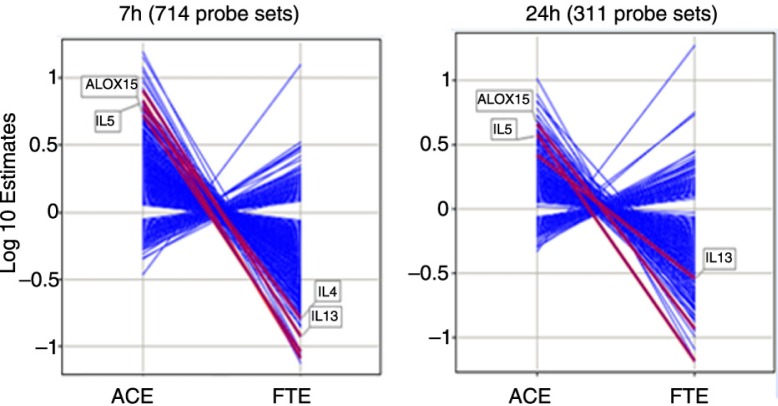
Log 10 estimates of gene expression changes for the significant genes identified from contrast analysis at 7 hours and 24 hours with an FDR < 0.025. ACE: allergen challenge effect, estimates of changes from baseline in the placebo group. FTE: fluticasone effect, estimates of differences in change from baseline between the placebo and the fluticasone groups.